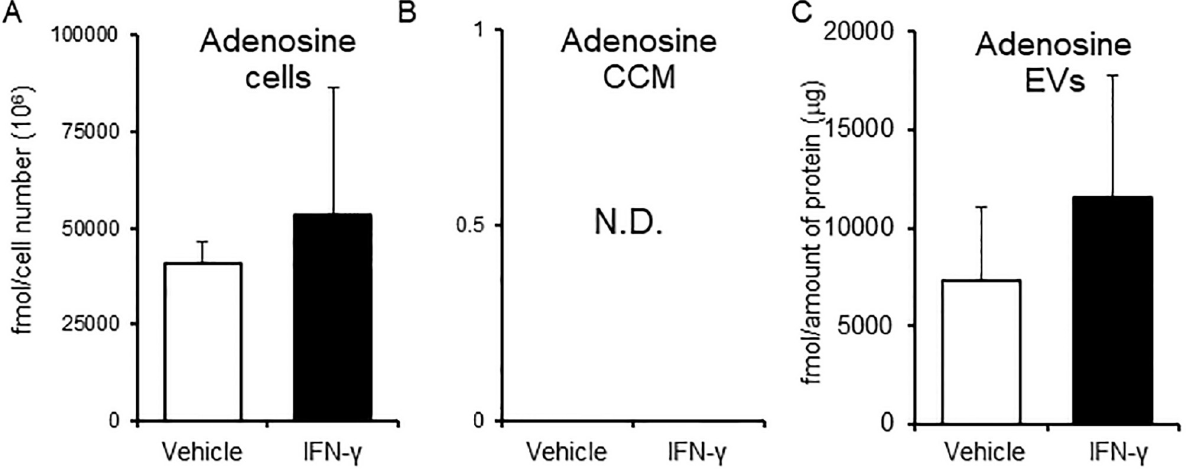
Fig 4. Adenosine concentration in cells, cell culture medium (CCM), and EVs. (A)–(C) Adenosine concentrations. D3H2LN cells were incubated in EV medium with or without IFN- γ . After 48 h, cells and supernatant were collected. The supernatant was ultra-centrifuged to separate EVs from the CCM. For metabolome analysis, cells and CCM samples were subjected to CE-MS, and EV samples were subjected to IC-MS and LC-MS. The amount of metabolites was normalized to the amount of protein. Columns, average concentration ((A), fmol/cell number (10 6 ); (C), fmol/mg protein). Bars, S. D. (n = 3). N.D., the metabolite concentration was below the detection limit of the assay. All experiments were performed using three biological replicates.